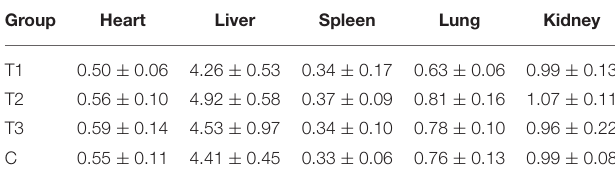
TABLE 5 | Organ index of mice immunized with different plasmids (100 ×